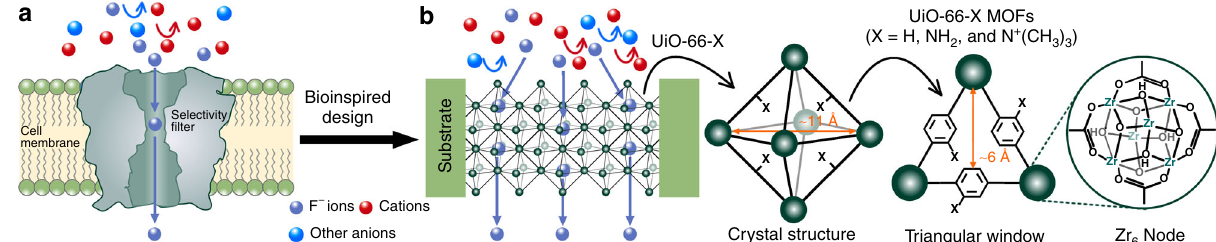
Fig. 1 Bioinspired design of synthetic MOF channels for fl uoride ion conduction. a Schematic of a biological fl uoride (F − ) ion channel with an angstrom- sized region as F − selectivity fi lter and nanometer-sized vestibule and outlet for selective, ultrafast F − transport. b Schematics of bioinspired arti fi cial zirconium-based UiO-66-X (X = H, NH 2 , and N + (CH 3 ) 3 ) MOF channels with sub-1-nanometer crystalline pores for selective and ultrafast F − transport. Sub-1-nanometer MOF channels consist of angstrom-sized triangular windows (~6 Å in diameter) for ion sieving and nanometer-sized octahedral cavities (~11 Å in diameter) for ultrafast ion conduction